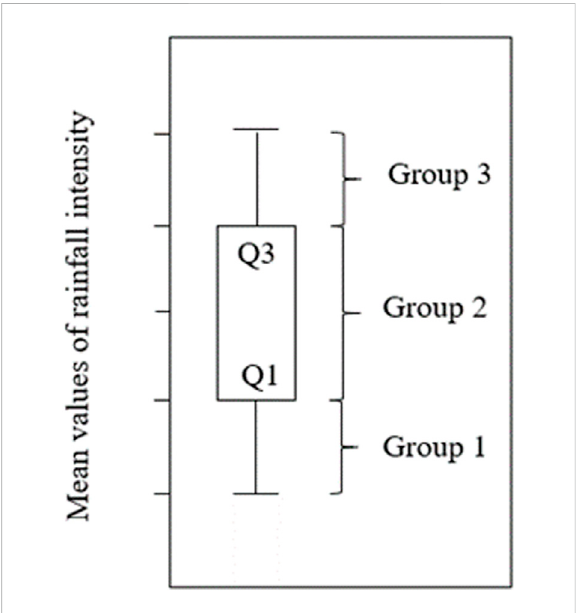
FIGURE 6 Information on the criteria classi fi cation of each rainfall event group. Group 1 includes nine rainfall events that having lowest mean rainfall intensity values (namely, events 3, 8, 9, 10, 11, 20, 29, 35, and 37), while group 3 contains nine rainfall events that havinghighestmeanofrainfallintensityvalues(namely,event1,13, 17, 21, 23, 24, 26, 27, and 33). The remaining 19 rainfall events are classi fi ed into group